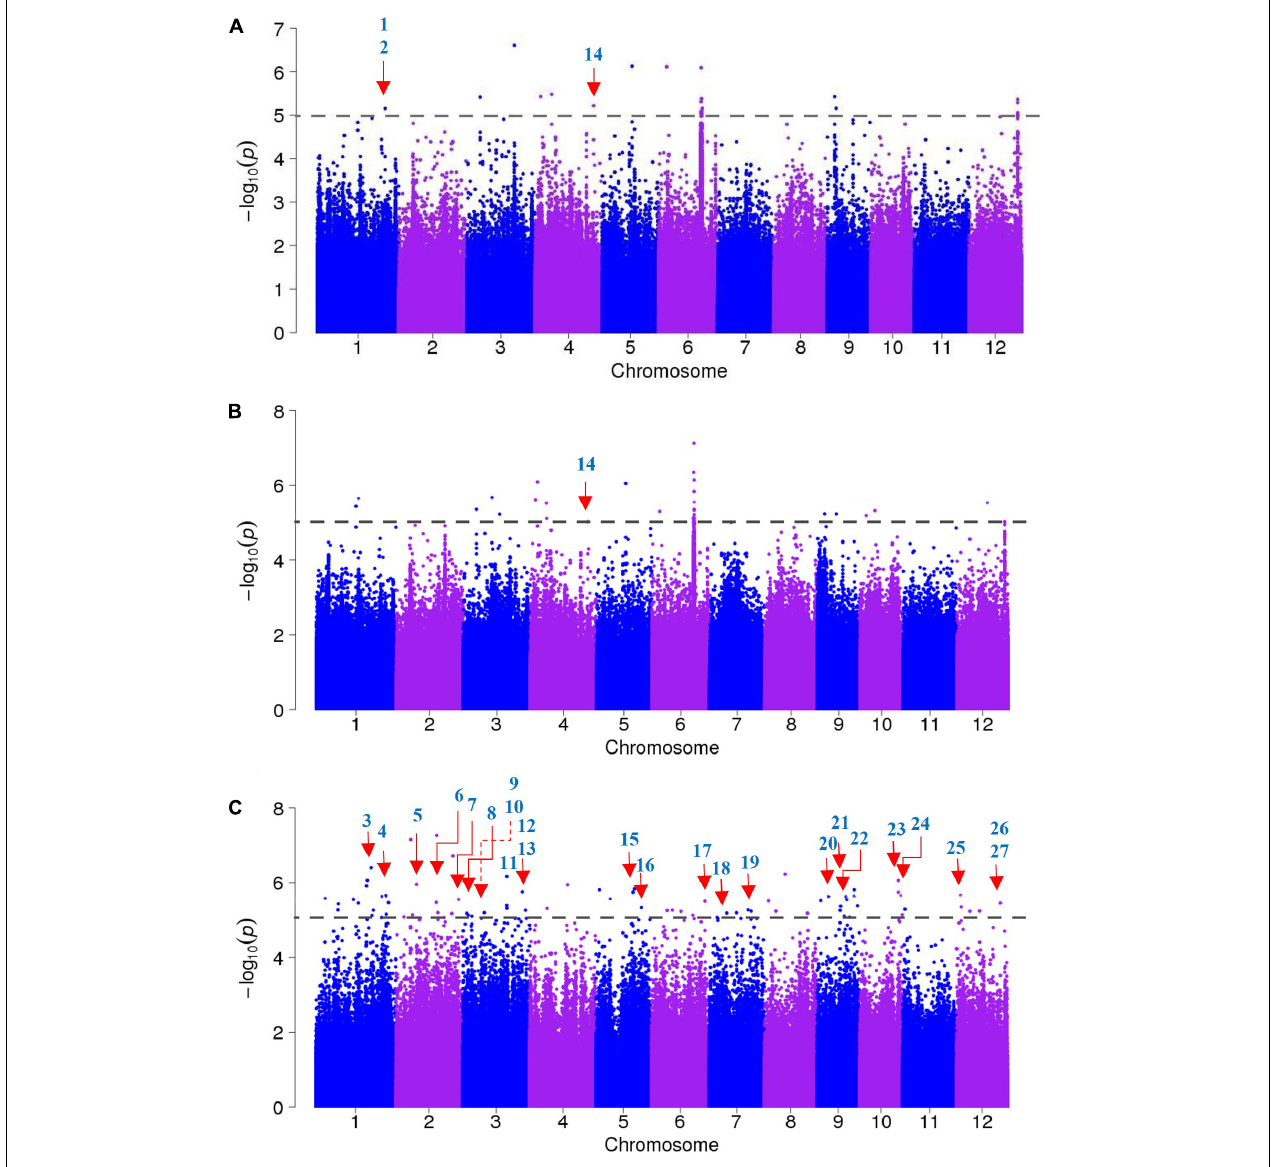
FIGURE 3 | Genome-wide association studies of salt tolerance evolution scores (SES). (A) Manhattan plots of the entire accessions panel, (B) the indica accessions panel, (C) the japonica accessions panel. The known candidate genes responsible for salt sensitivity are indicated with red arrows, the numbers correspond to the genes presented in Table 2